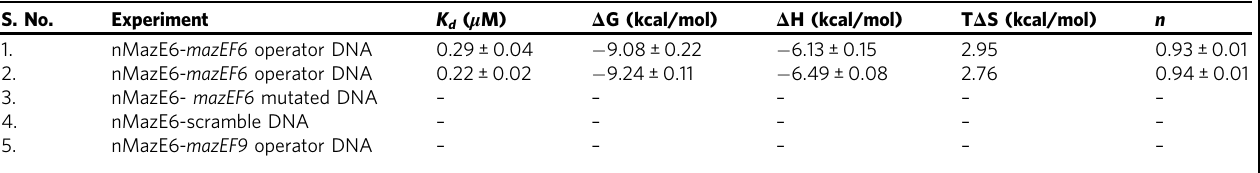
Table 2 Thermodynamic and kinetic parameters derived for interaction of nMazE6 with operator DNA constructs. Thermodynamic parameters derived from ITC experiments for interaction of nMazE6 with different DNA S.